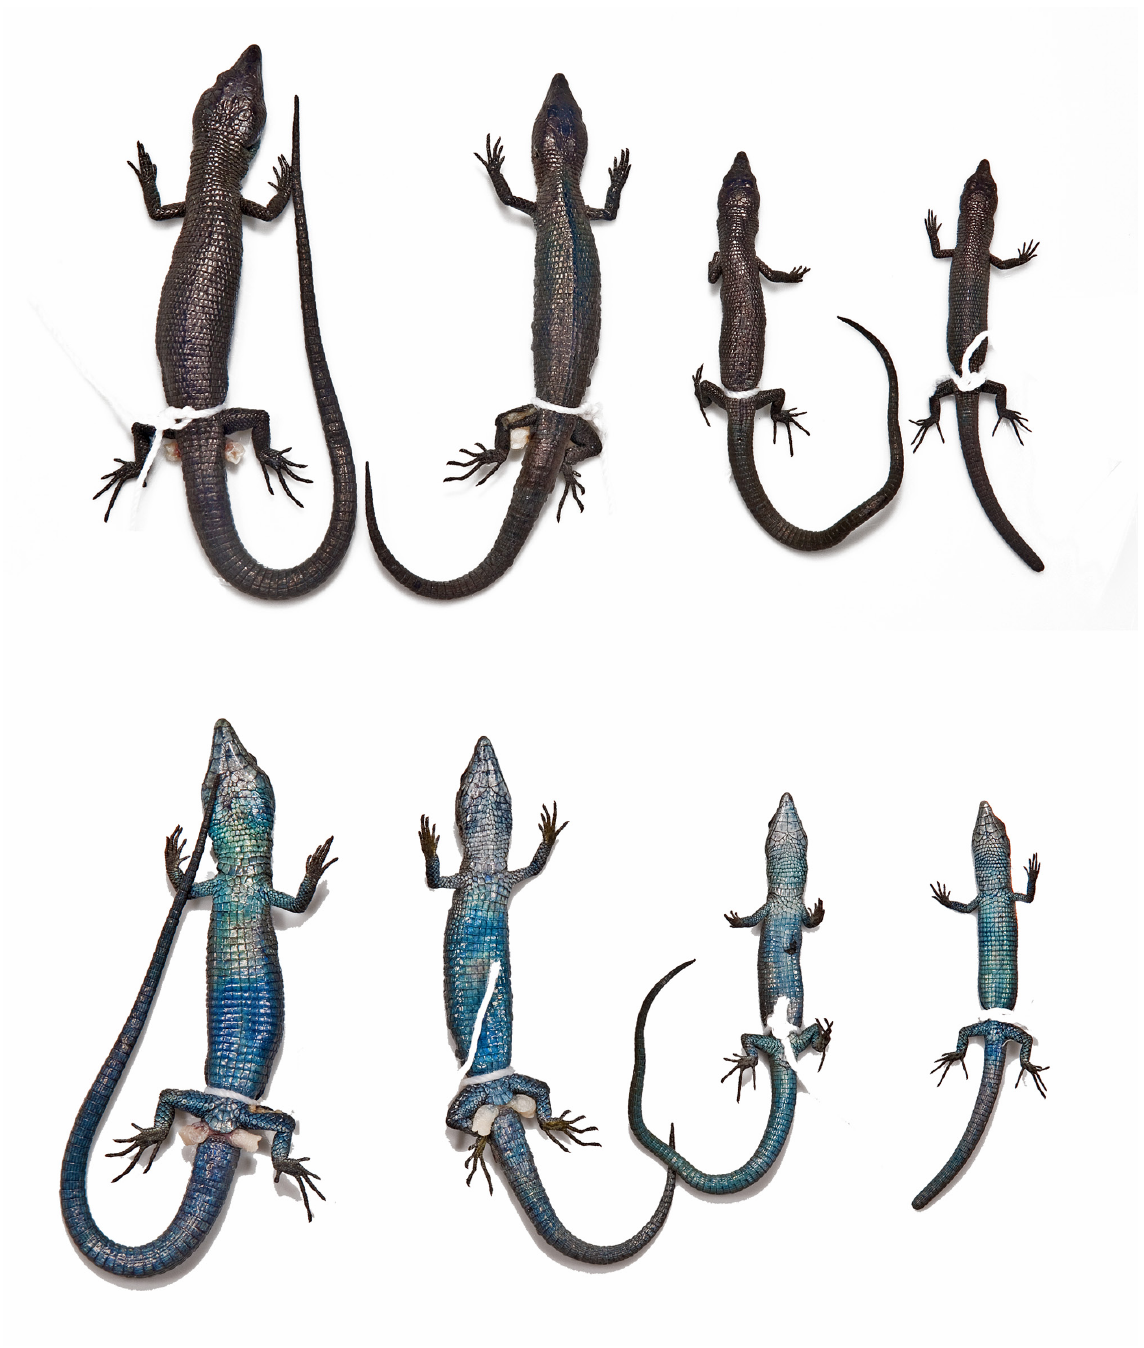
Fig. 6. Anadia mcdiarmidi sp. nov. Intrapopulation variation in dorsal (above) and ventral (below) colour pattern in preserved specimens. From left to right: IRSNB 2677, IRSNB 2674, IRSNB 2676, IRSNB 2675. Photographs by Philippe J.R.